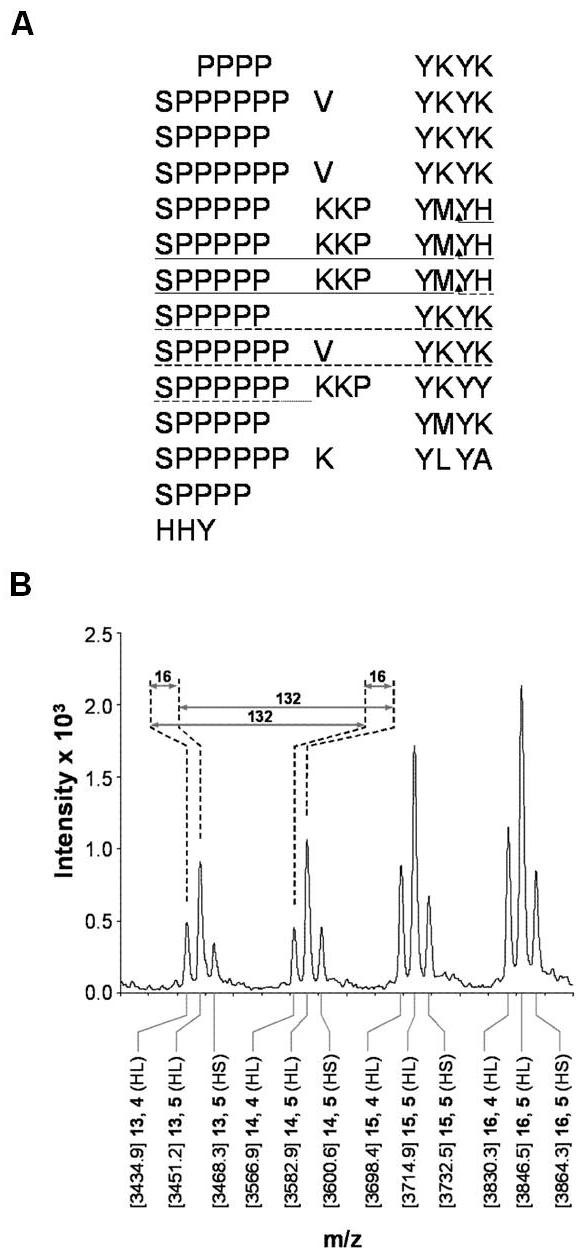
GvP1 shows characteristics of typical, dicotyledon extensins. A) Partial sequence of GvP1 deduced from its 5' truncated cDNA. Sequences obtained by Edman sequencing of isolated GvP1 peptides P4 (dashed line) and P6 (solid line) are indicated. CNBr cleavage sites are indicated by arrows. B) MALDI-TOF MS of Peptide 6 demonstrates mass heterogeneity due to variable arabinosylation (periodicity of 132 Da) and hydroxylation of proline residues (periodicity of 16 Da). The differing ion species are labelled along the x-axis with: [mass] number of Ara, number of Hyp (its identity as a homoserine (HS) or homolactone serine (HL) cleavage product).